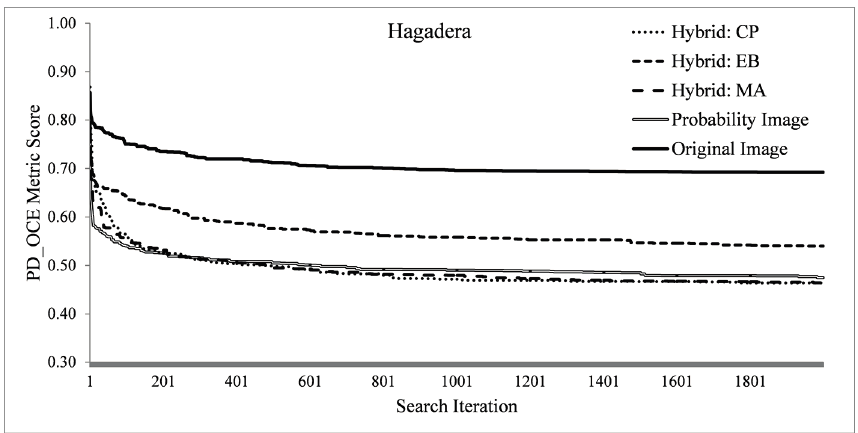
Figure 14. Fitness traces for the Hagadera problem